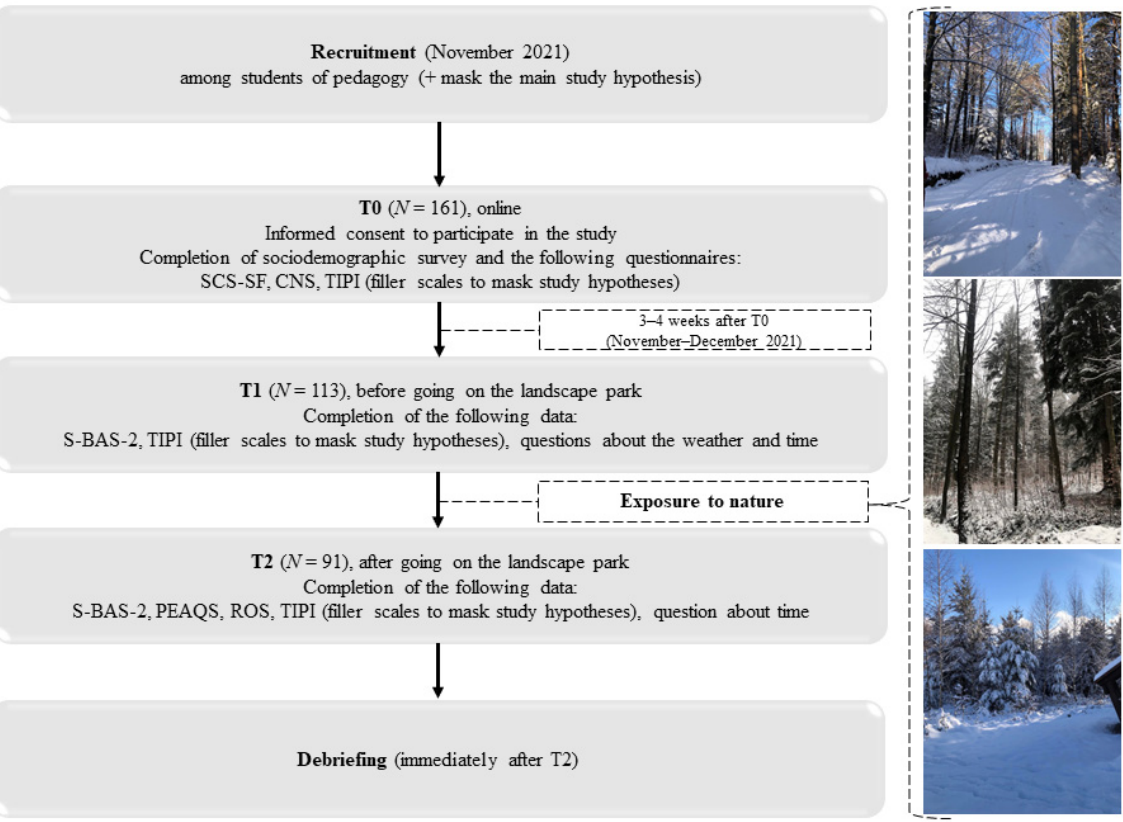
Figure 1. Flow diagram of participants and measurements throughout the study .